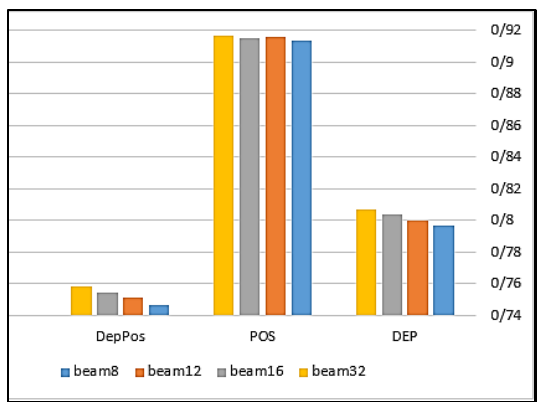
Figure 4. Study of relationship between beam size and accuracy on English.